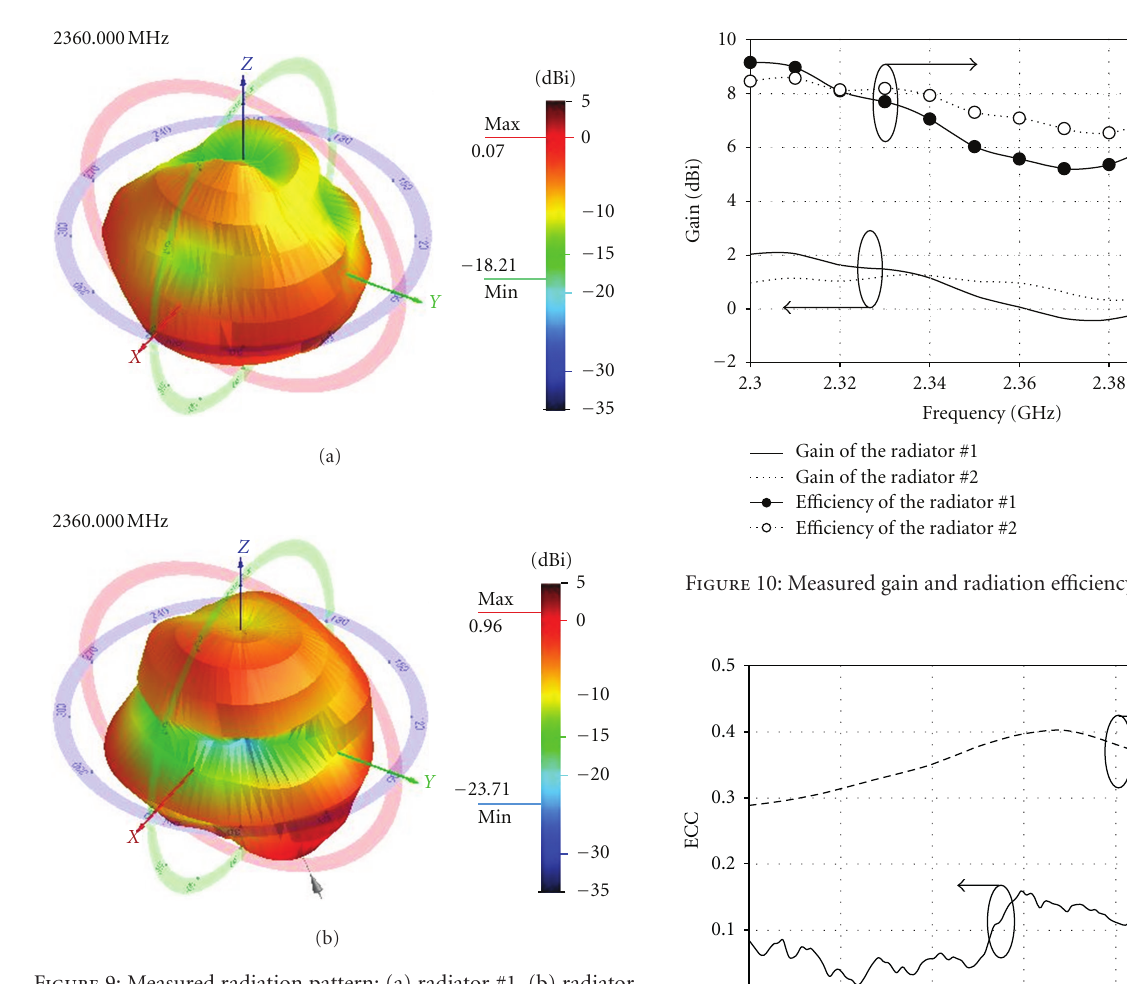
Figure 9: Measured radiation pattern: (a) radiator #1, (b) radiator #2.